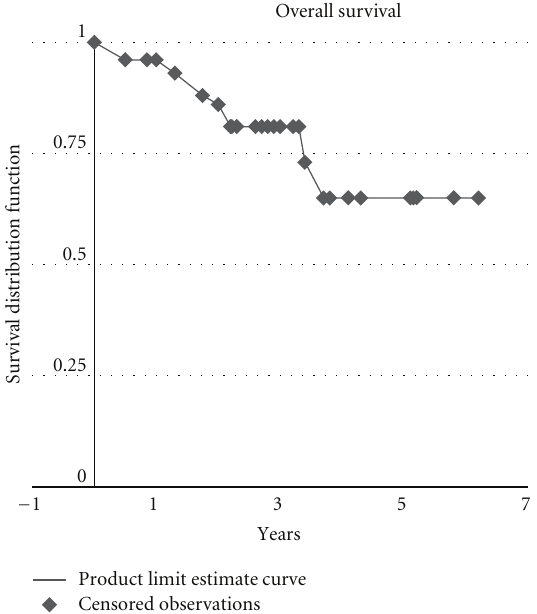
Figure 1: Primary site disease control in advanced head and neck cancer treated with postradiotherapy neck dissection.